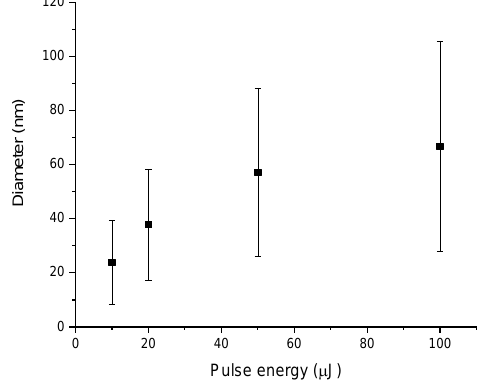
Figure 4. Diameter of spherical Sm oxide NPs obtained by laser ablation at different pulse energies. Data points and scale bars represent mean size and standard deviations from lognormal fit of number-weighted size hystograms.